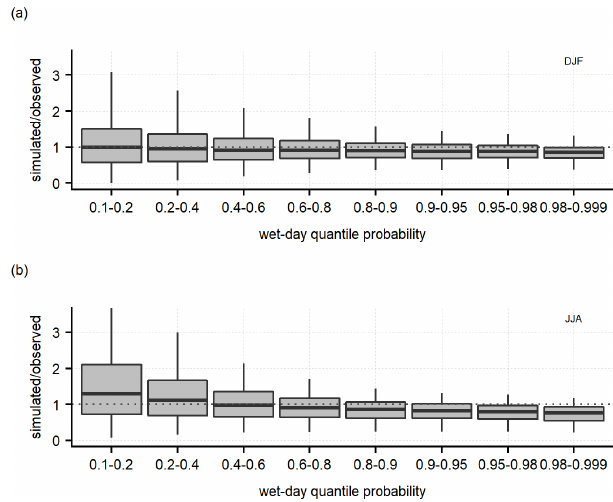
Figure 6. Ratio between daily simulated and observed precipita- tion (wet days only) in (a) winter and (b) summer over 1980–2010 grouped for quantiles. Boxplots extend over the interquartile range with the median reported by the bold line, while whiskers extend over the full range of outliers.